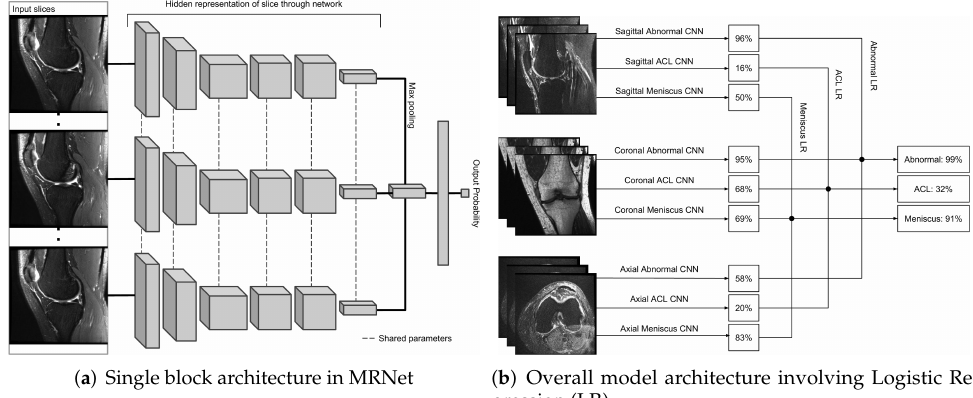
Figure 3. MRNet model architecture: ( a ) single block, ( b ) overall